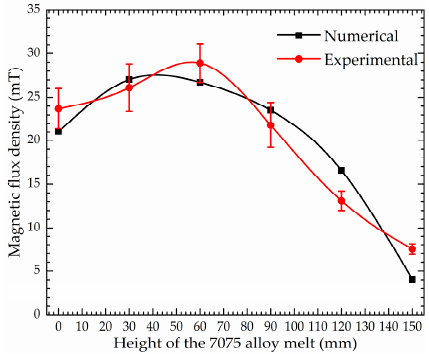
Figure 10. Comparison between simulated and measured magnetic flux density.